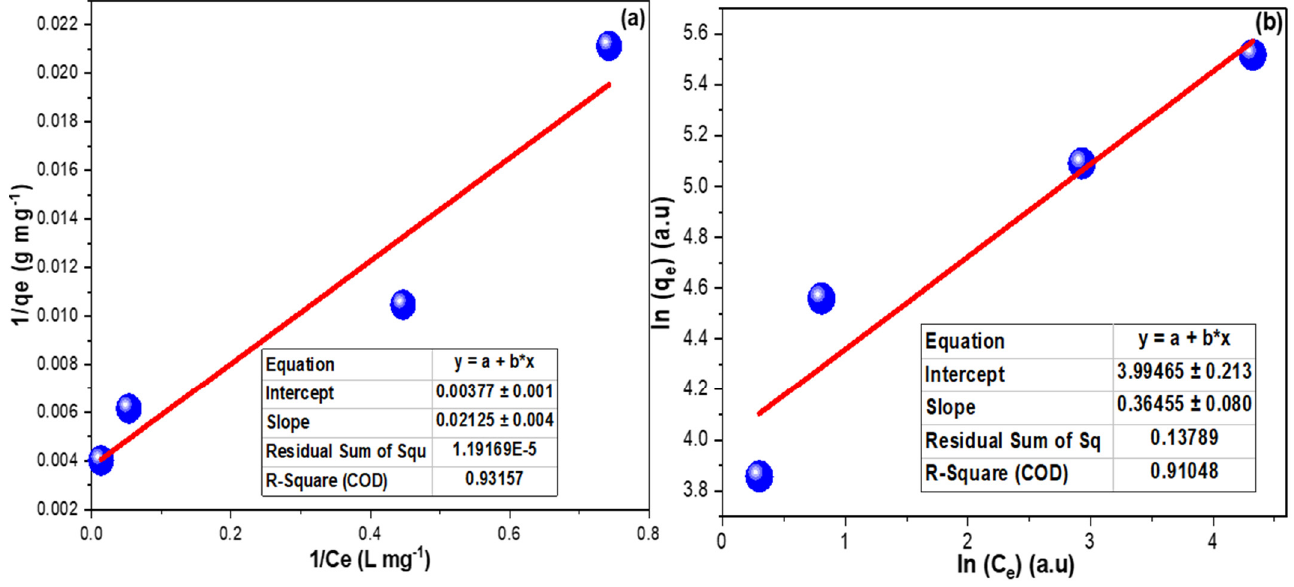
Figure 9. ( a ) LI and ( b ) FI investigations for the adsorption of IGC dye on the Al 2 O 3 -NiO nanocom-